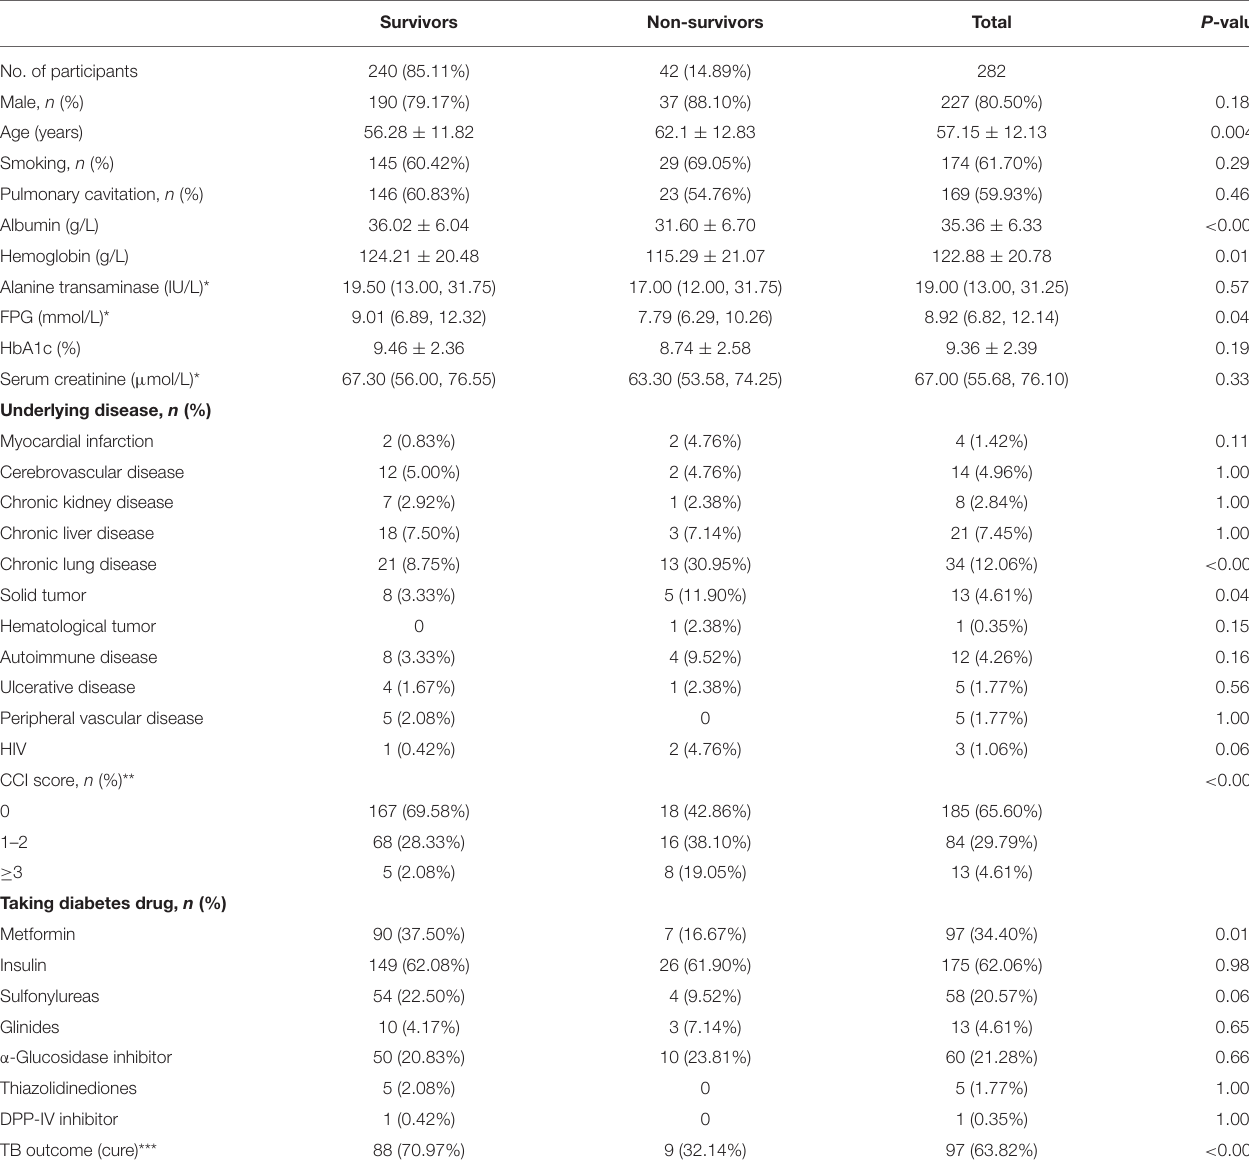
TABLE 1 | The demographic and clinical parameters of patients with pulmonary TB and type 2 diabetes comorbidity at baseline visit. Survivors Non-survivors Total P